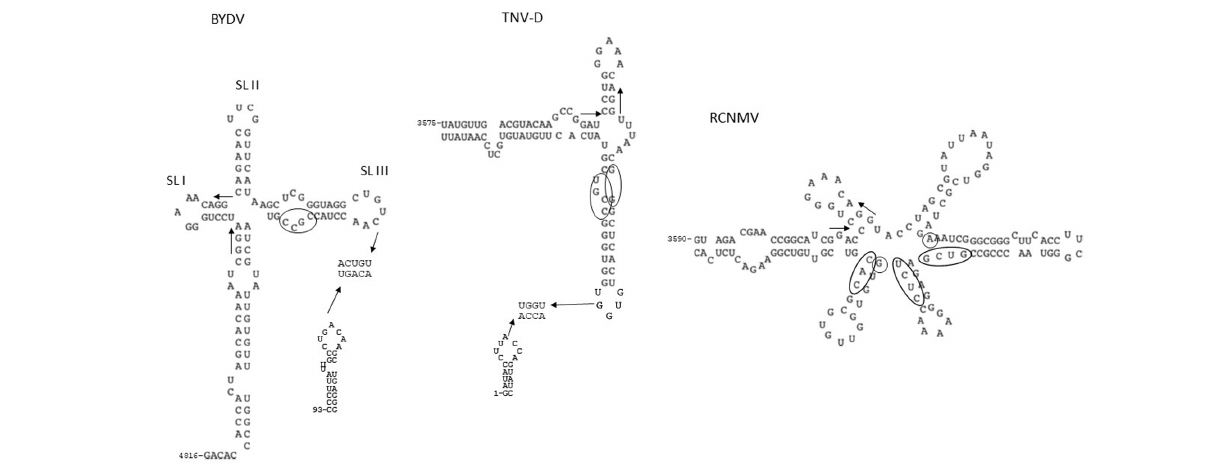
Elderberry latent virus (ELV), Rosa rugosa latent virus (RrLDV) and Pelargonium ringspot virus (PelRSV) (Blanco-Pérez et al., 2016) and additionally in Calibrachoa mottle virus (CbMV), a member of the genus Carmovirus (Simon and Miller,